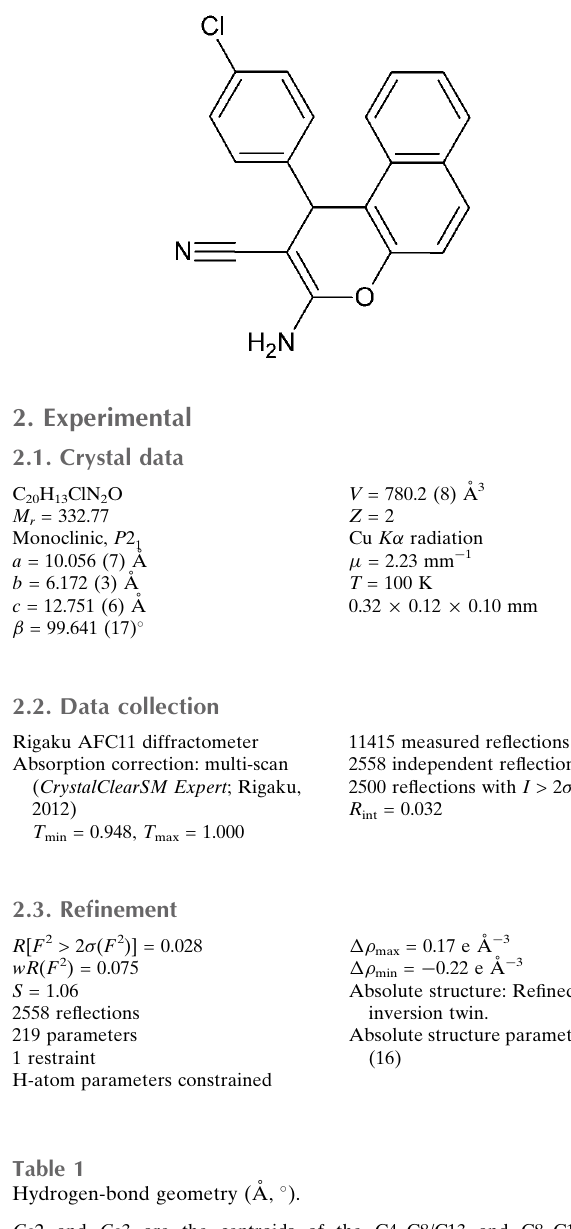
Hydrogen-bond geometry (A˚ , (cid:2) ). Cg 2 and Cg 3 are the centroids of the C4–C8/C13 and C8–C13 rings, respectively.